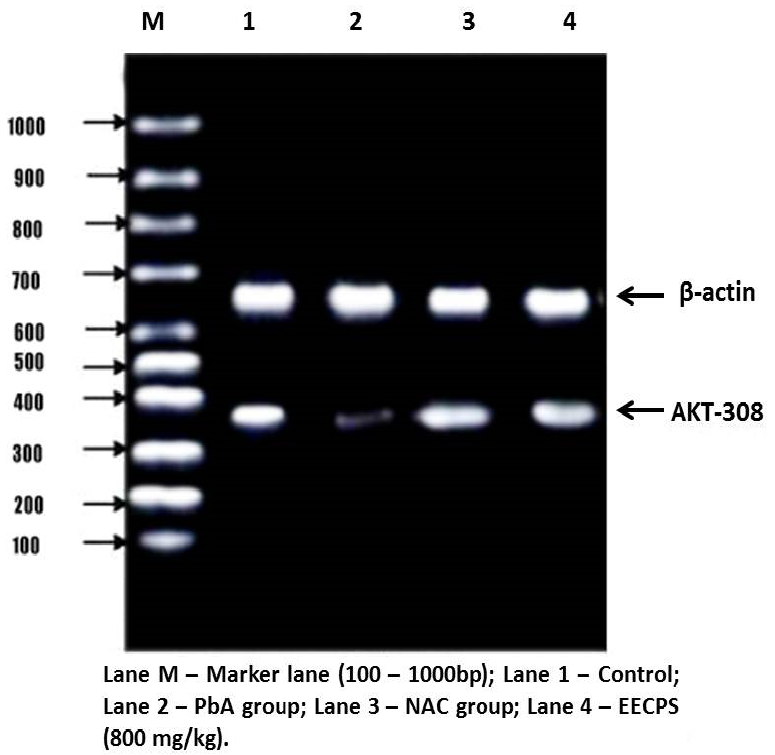
Figure 8. Agarose gel electrophoretic pattern of AKT mRNA expression in the kidney. The lane identities are indicated below the image.